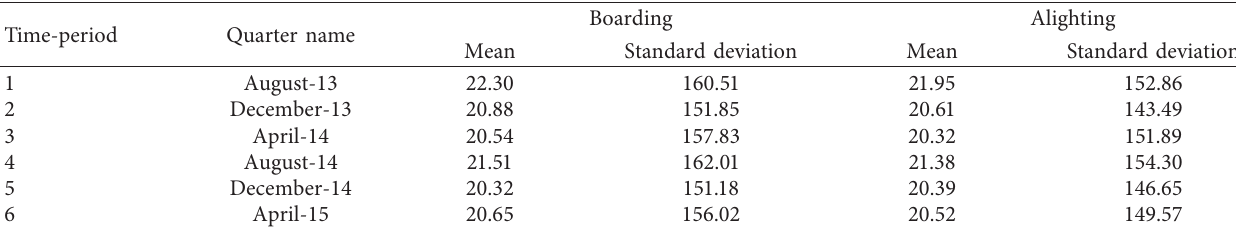
Table 1: Summary statistics of Lynx bus ridership (August 2013 to April